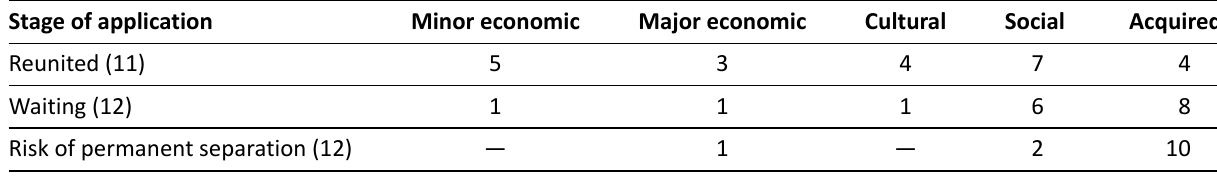
Table 1. Resources of forced migrants attempting family reunification. Stage of